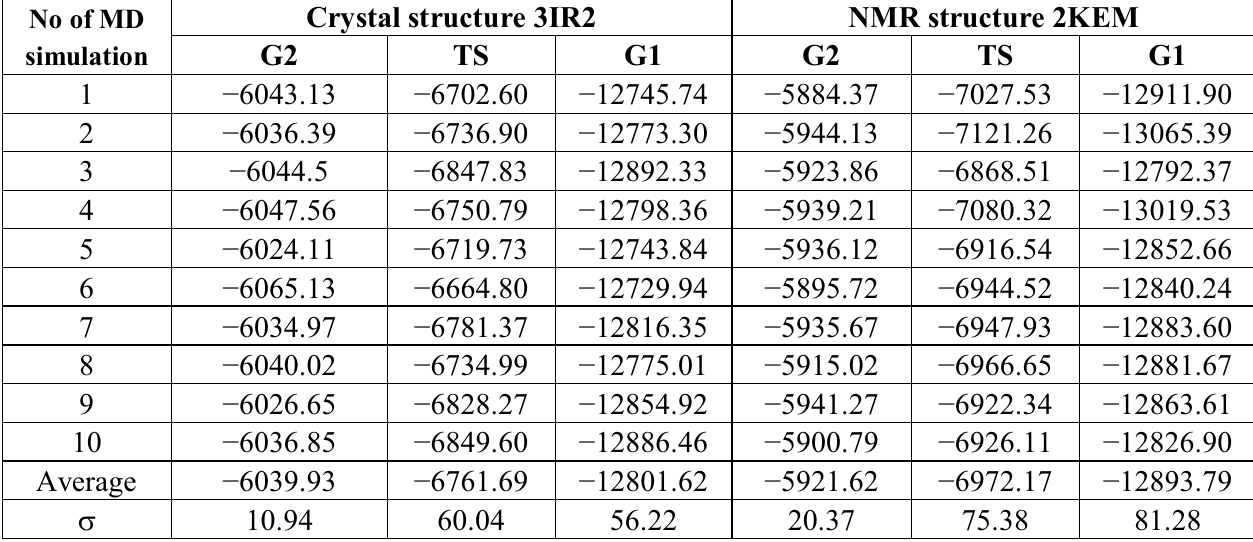
Table 4. Free energy and protein entropy term obtained from 20-ns MD simulation. No of MD